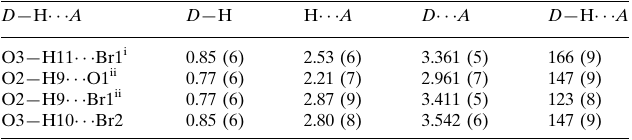
Hydrogen-bond geometry (A˚ , (cid:2)